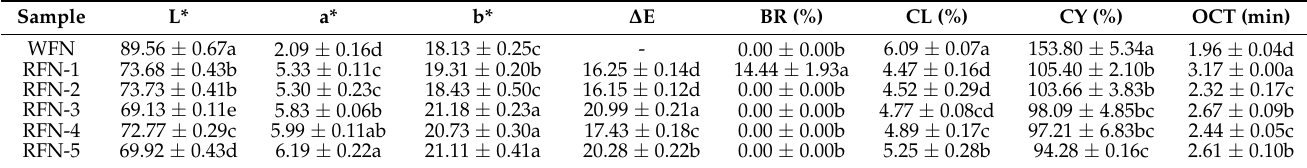
Table 4. Effect of highland barley flour with different particle sizes on the color and cooking charac- teristics of